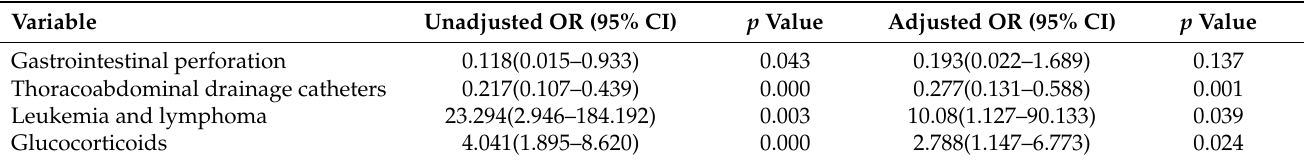
Table 7. Multivariate analysis of factors with respect to patients with C. albicans vs. C. tropicalis